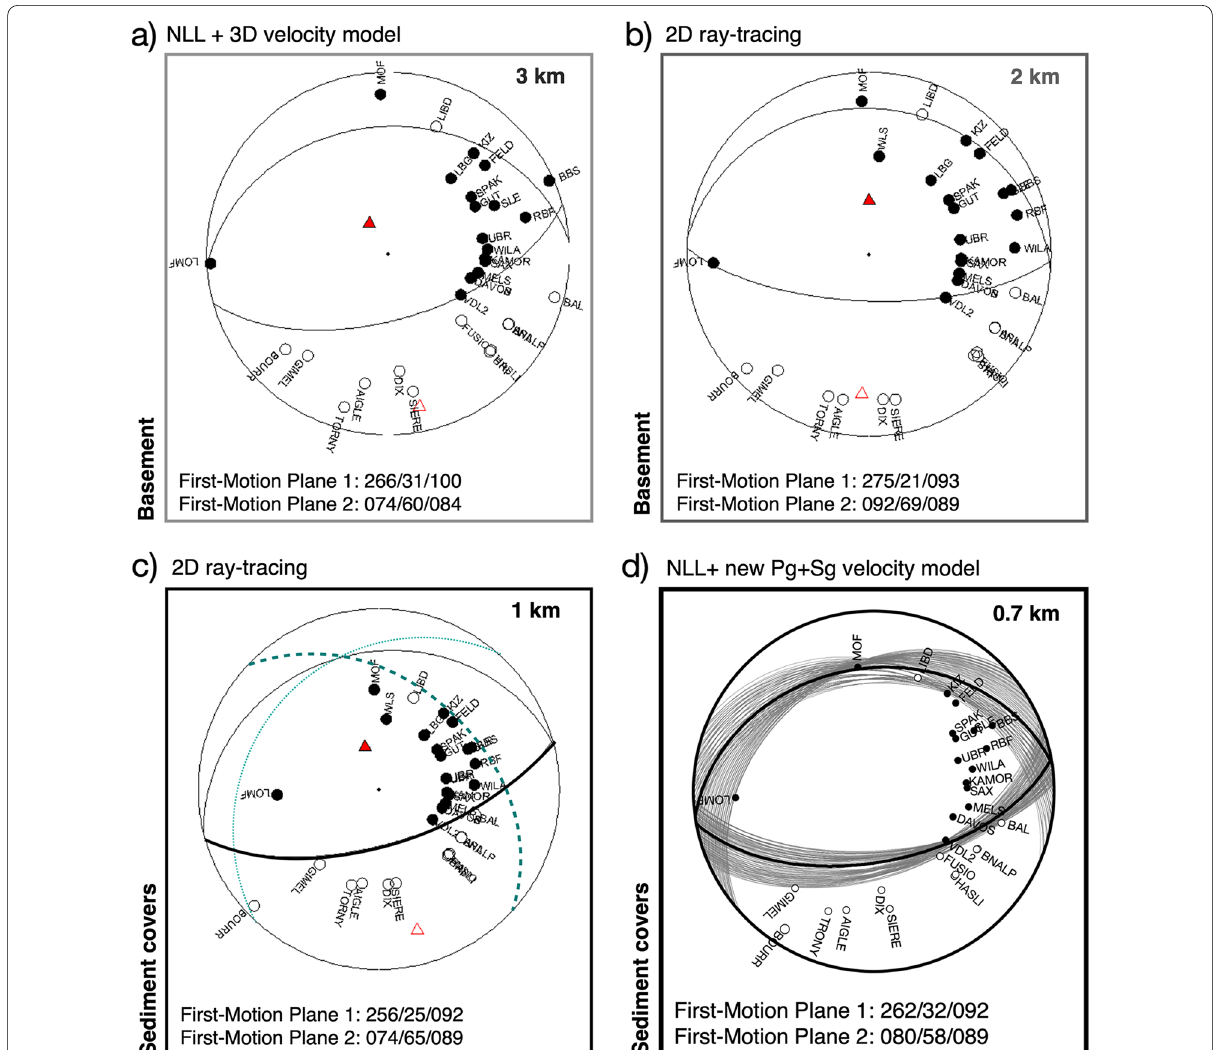
Fig. 10 First-motion focal mechanisms solutions for the M L 3.2 event of April 6th, 2000 based on a take-off angles calculated routinely with NonLinLoc (NLL) and the 3-D model of Husen et al. (2003); b take-off angles based on 2-D ray-trace models for focal depths in the basement (2 km); c and in the sediments (1 km); here with different lines styles and colors are indicated those nodal plane solutions for which an equally good fit is obtained. d take-off angles calculated with NonLinLoc, the new 3-D Pg Sg model (Diehl et al., 2021) and a focal depth of 0.7 km BSL. Stereogram + is lower hemisphere, equal-area projection. Solid circles correspond to compressive first motion (up); empty circles correspond to dilatational first motion (down). Grey lines in d) show sets of acceptable solutions derived by the HASH algorithm (Hardebeck & Shearer, 2002); black bold lines indicate the (preferred) average focal mechanism of all accepted solutions. For all cases, strike, dip, and rake of the two focal planes are provided below each